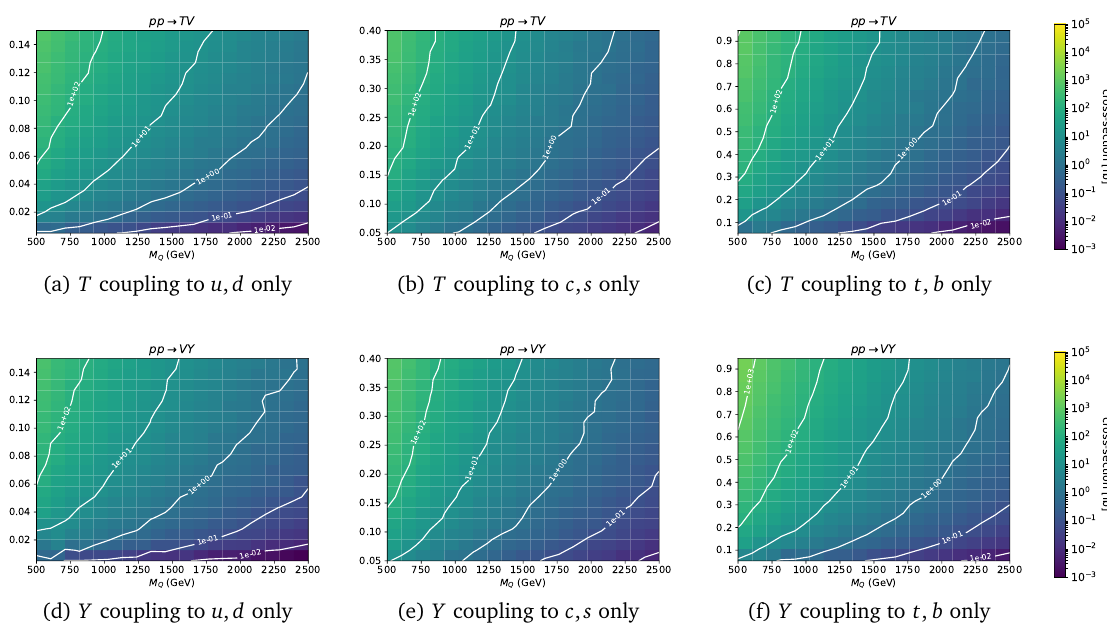
Figure 3: Leading-order cross-sections extracted from Herwig for production of a T and Y with a weak boson as a function of M and κ , for 13 TeV pp collisions, in the Q W : Z : H = 1 scenario, assuming couplings to individual generations of quarks. : 1 : 1 2 4 4 The white lines indicate the contours for production cross-sections in multiples of 10. First-generation couplings lead to higher production cross-sections, as a result of valence-quark-induced diagrams, while second and third-generation couplings lead to suppressed production rates, according to the relevant quark